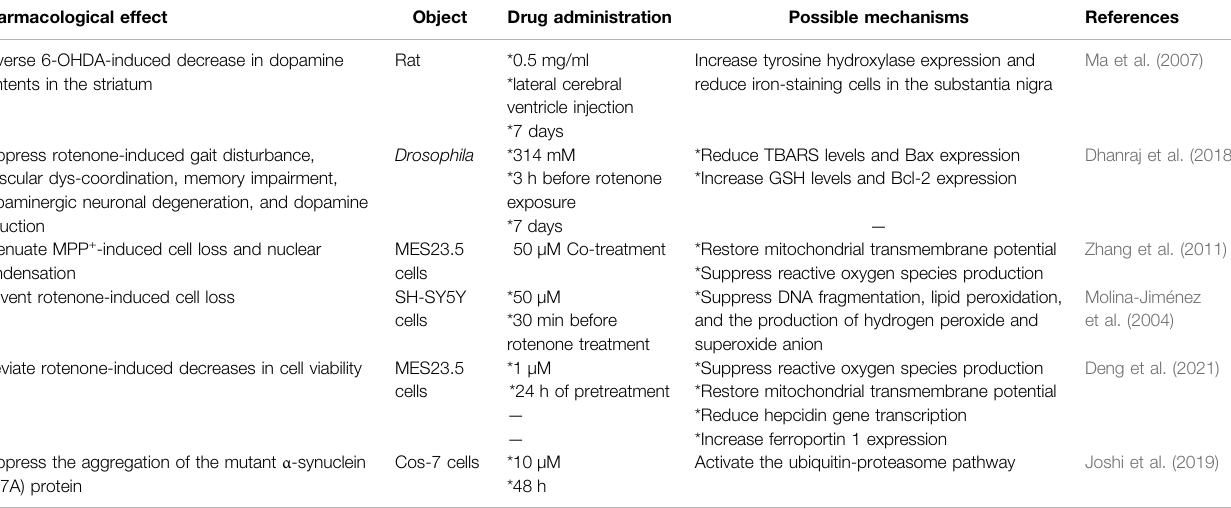
TABLE 3 | Comprehensive information about the effects of myricetin in animal models Parkinson ’ s